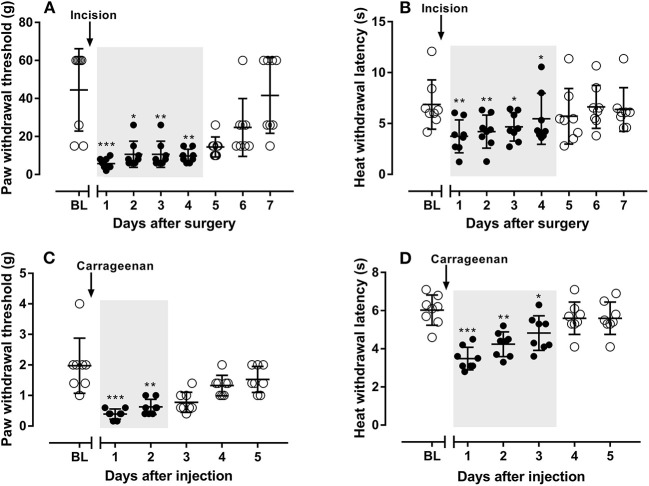
The development of mechanical (A) and heat (B) hypersensitivities in rats after incision in their hand paws, and the development of mechanical (C) and heat (D) hypersensitivities in mice after carrageenan injection in their hand paws. N = 8 animals, data were presented as mean ± SD. *P < 0.05, **P < 0.01, ***P < 0.001, mechanical (A,C) or heat thresholds (B,D) from Day 1 to 7 in rats (A,B) or from Day 1 to 5 in mice (C,D) were compared with their baseline values, using Dunn's (A,C) or Dunnett's multiple comparisons test (B,D) following ANOVA. Gray shaded areas represent durations that rats or mice experiencing ongoing hypersensitivities.